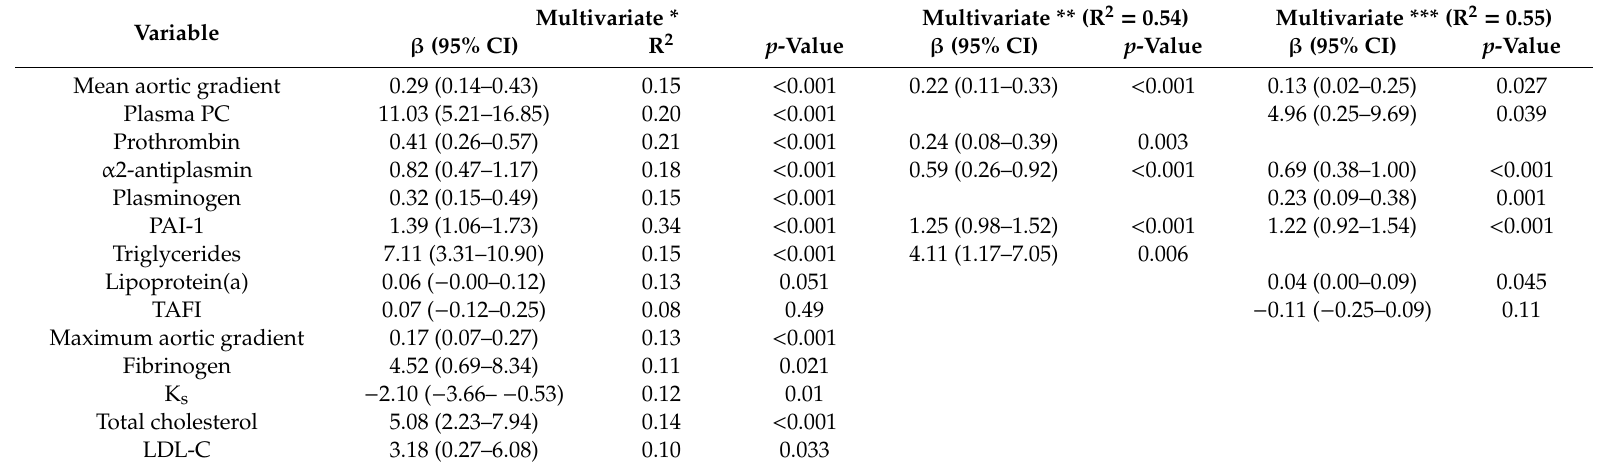
Table 2. Associations between clot lysis time and echocardiographic and laboratory